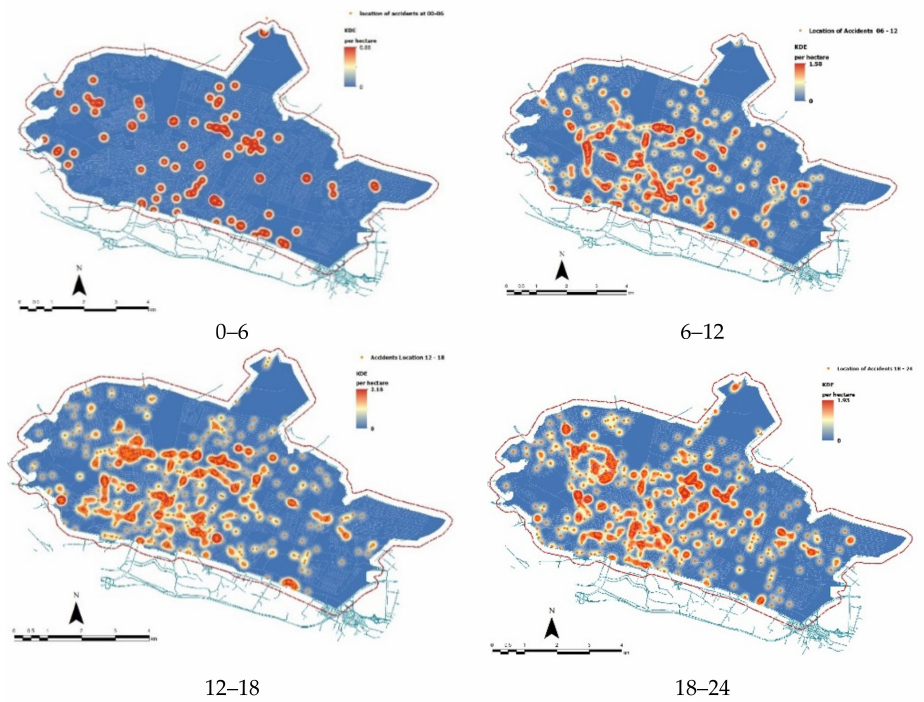
Figure 4. Density of road accidents (per hectare) density by time of the day (four classes covering 6 h each).